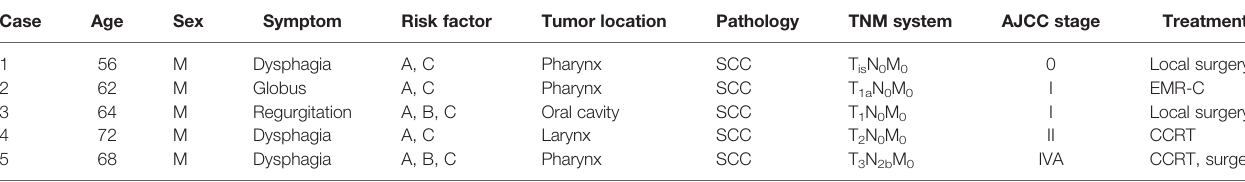
TABLE 3 | Characteristics of fi ve newly diagnosed head and neck